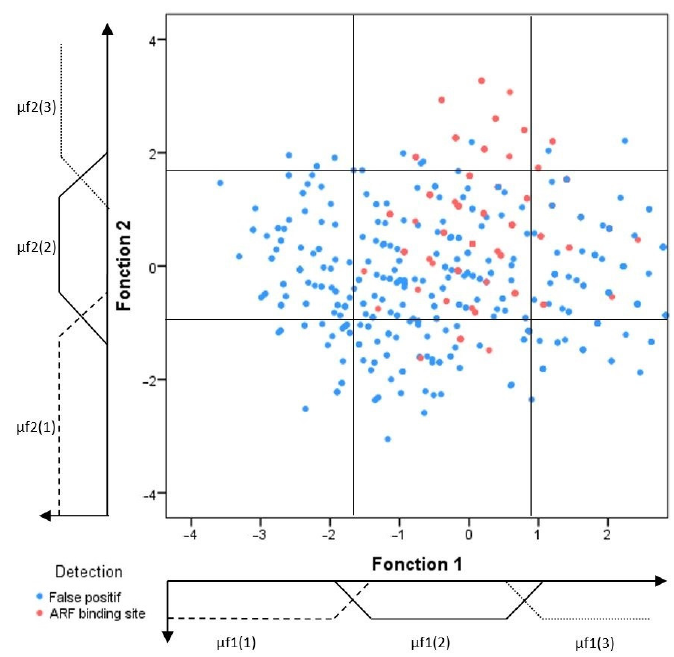
Figure 3. Feature space of the two first discriminative functions linear discriminant analysis of the represented training sets distribution of the ARF-binding sites (red color) and false positives (blue color). Three fuzzy sets and their corresponding membership degree functions ( μ F1(i) and F2(j)) were defined for each feature, yielding nine regions. The different sets of boundaries were determined through a learning step as much as possible to delimit discriminative regions.